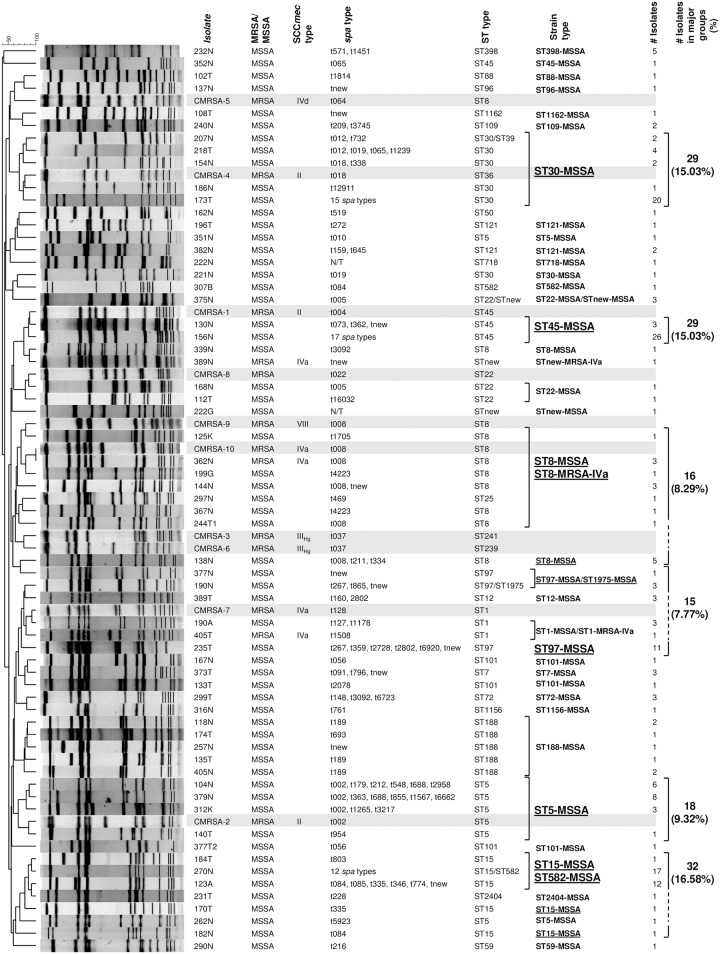
Molecular and genotypic characteristics of Staphylococcus aureus strains and isolates recovered from patients.Strains as described in the text, were identified using pulsed-field gel electrophoresis (PFGE) to identify major clonotypes. Isolates within each clonotype group were closely related, differing by only 2–3 bands. Molecular characterization identified 6 major types (underlined), these types were correlated with spa or MLST typing and are listed in the figure. All superscripts designations indicated either a new spa type or an unassigned type.